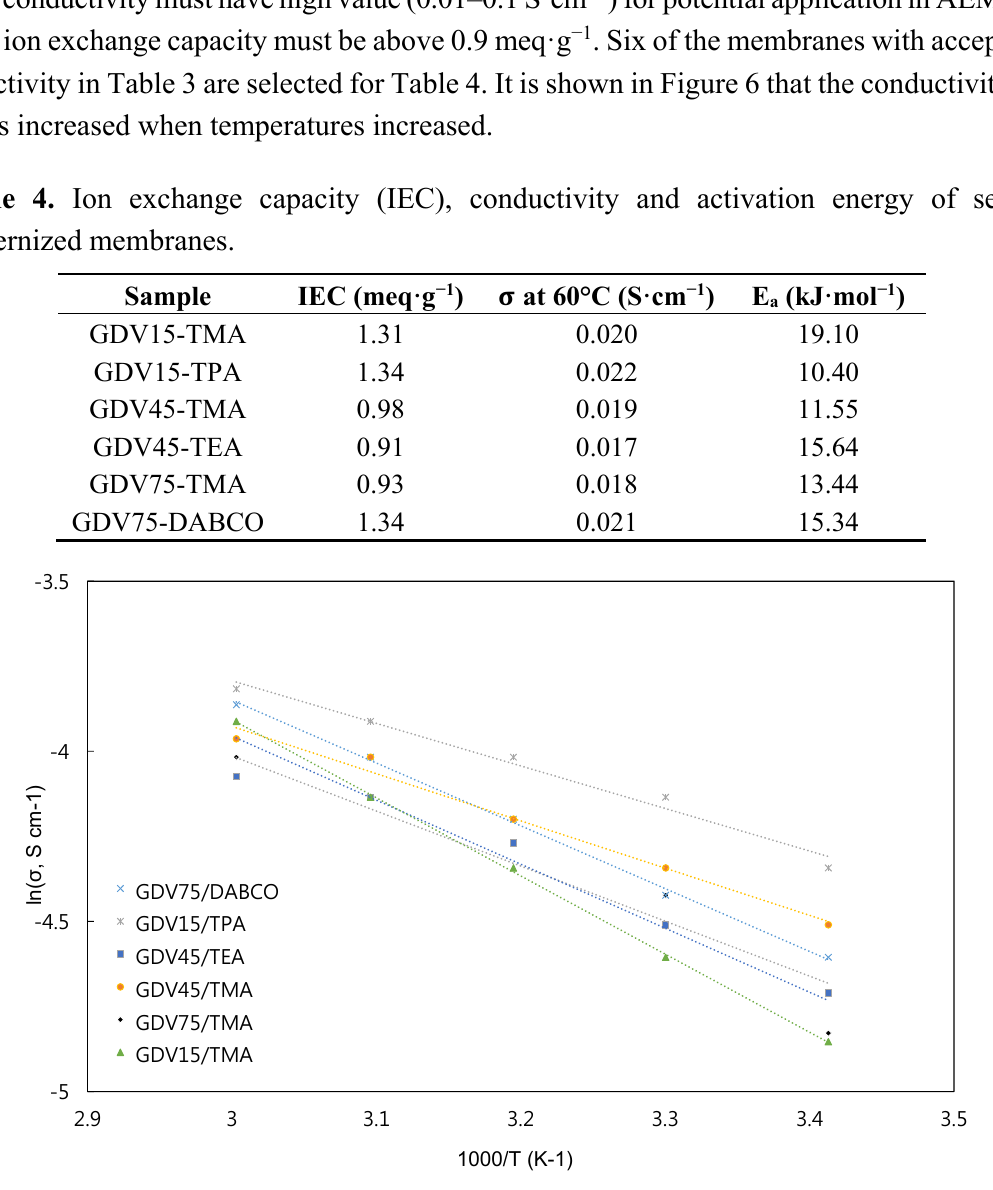
Figure 6. Arrehenius plots for GDV15-TMA, GDV15-TPA, GDV45-TMA, GDV45-TEA, GDV75-TMA, and